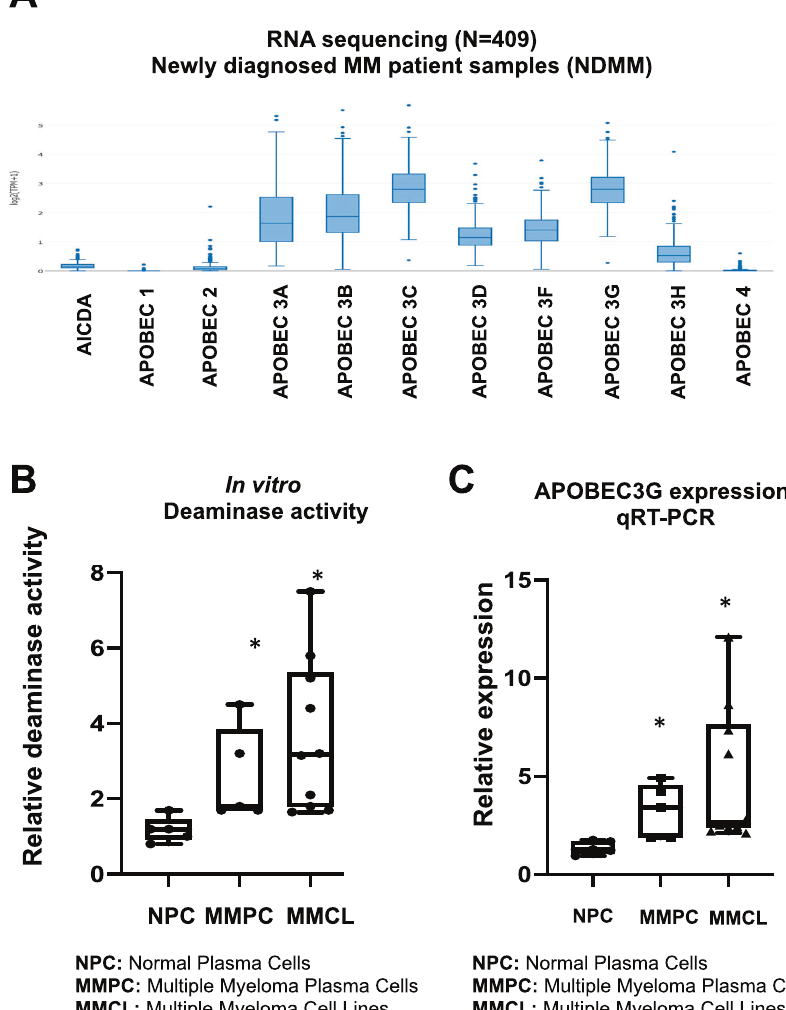
evaluated in the lysates of CD138 + plasma cells from normal donors (NPC) ( n = 5), newly diagnosed multiple myeloma patients ( n = 5), and myeloma cell lines ( n = 12); C Expression of APOBEC3G in CD138 + plasma cells from normal donors (NPC) ( n = 5), newly diagnosed multiple myeloma patients ( n = 5), and myeloma cell lines ( n = 12), evaluated by qRT-PCR. Asterisk indicates a p value <